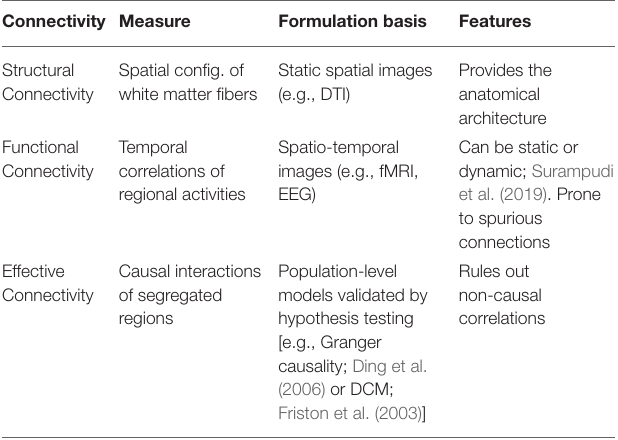
TABLE 1 | Complex brain networks are measured through Structural Connectivity (SC), Functional Connectivity (FC), or Effective Connectivity (EC). Computational Connectomics is a common ways of formulating structural and functional networks of the whole